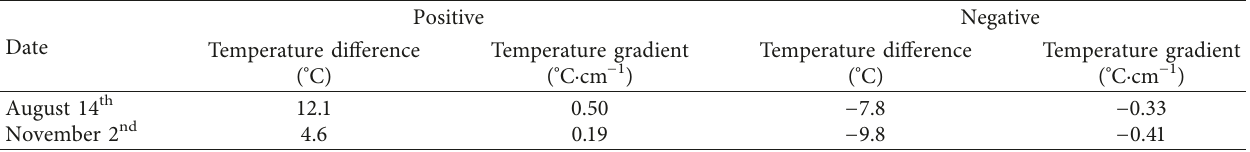
Figure 3: Nonlinear temperature gradient distribution in the concrete slab over different months. (a) August 14 th . (b) November 2 nd . Table 2: Maximum temperature differences and temperature gradients in the concrete slab over different months.